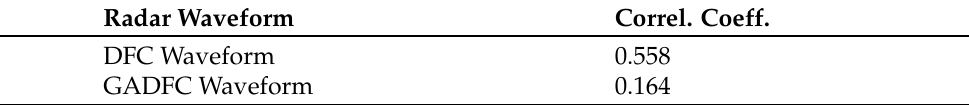
Table 1. Correlation Coefficient Between Adjacent Transmitted